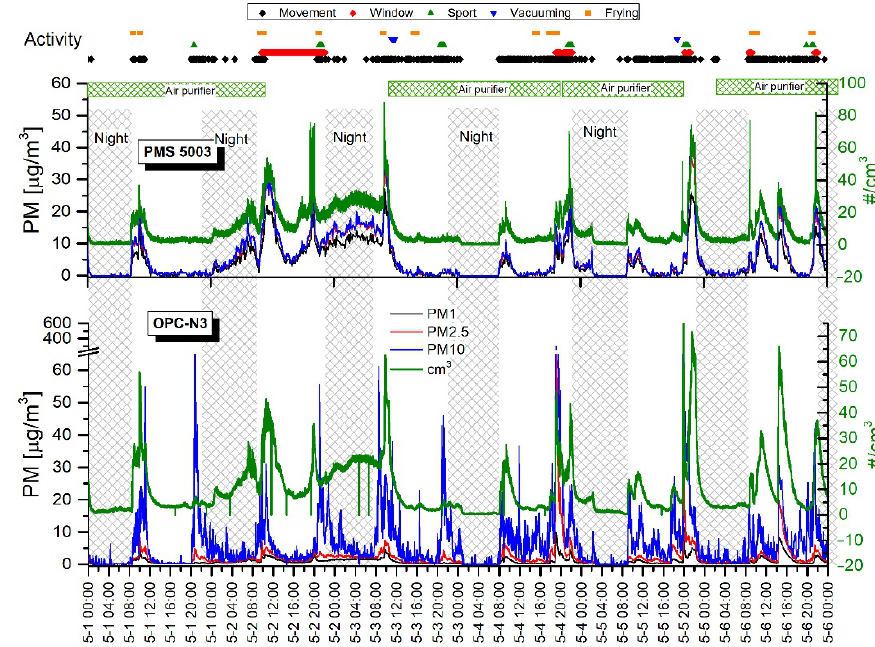
Figure 7. Variations in indoor mass concentrations of PM 1 , PM 2.5 , and PM 10 measured with the PMS5003 and OPC-N3 sensors for the second week. The green linear graph shows total particle counts for each sensor (right axis). The activity points on the top are common to both sensor graphs.